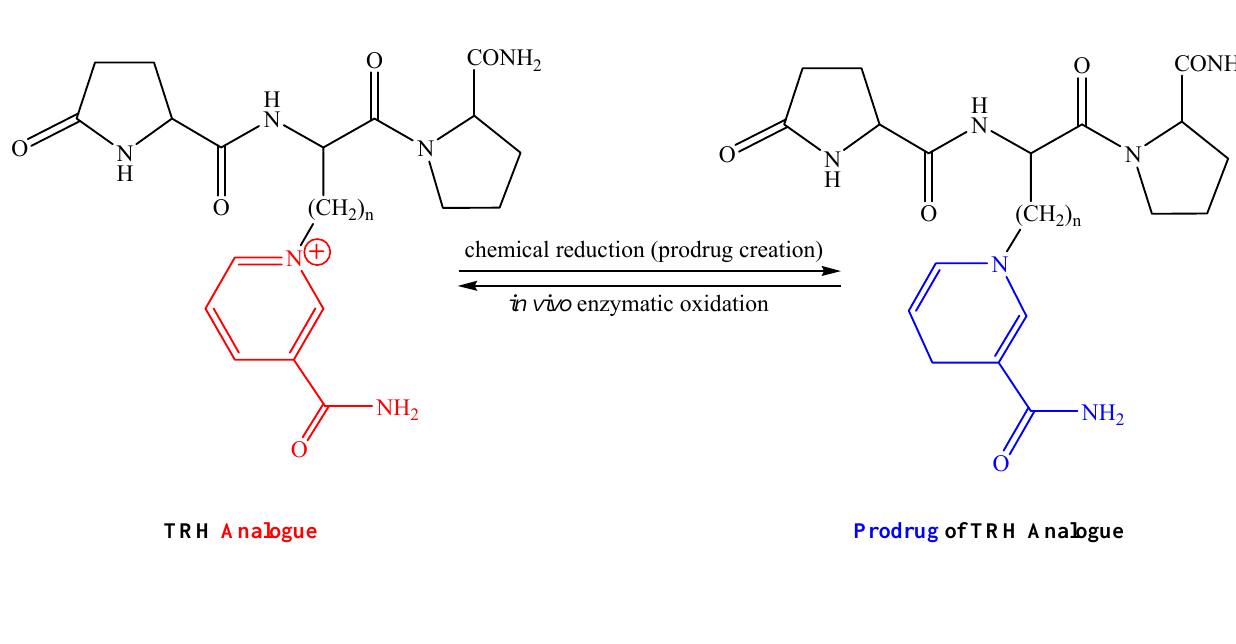
Figure 4. Prodrug-amenable [pyridinium 2 ]TRH analogues and their corresponding brain- targeting prodrugs